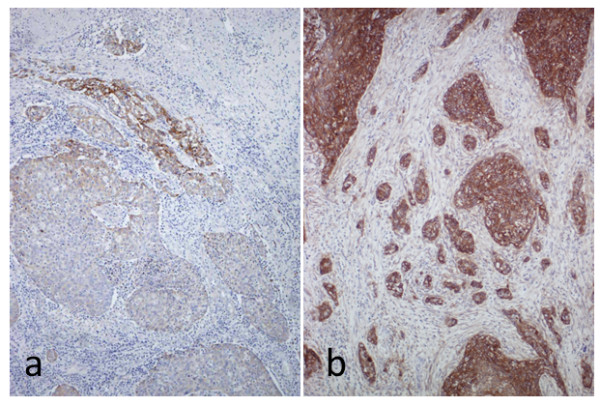
Staining for EGFR in representative HNSCC samples. The EGFR score (0-16) in tumor samples was calculated as a product of staining intensity (1-4) multiplied by the percentage of positive cells (0-4). Tumor sample with low EGFR expression and EGFR score 2 (a). Tumor sample with high EGFR expression and EGFR score 12 (b). Homogenous expression of EGFR was found in the membranes and cytoplasm of tumor cells (Mag. × 100).